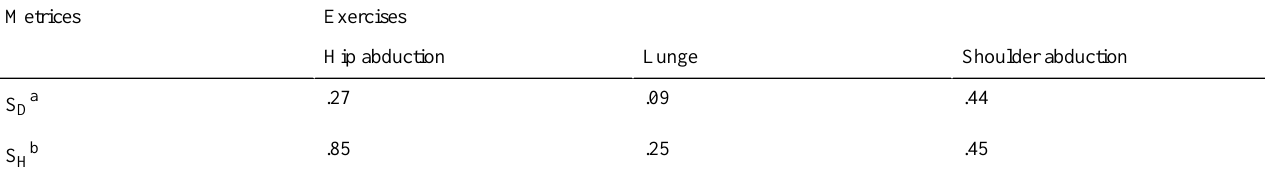
Table 1. P values obtained by applying the t test over the left and right